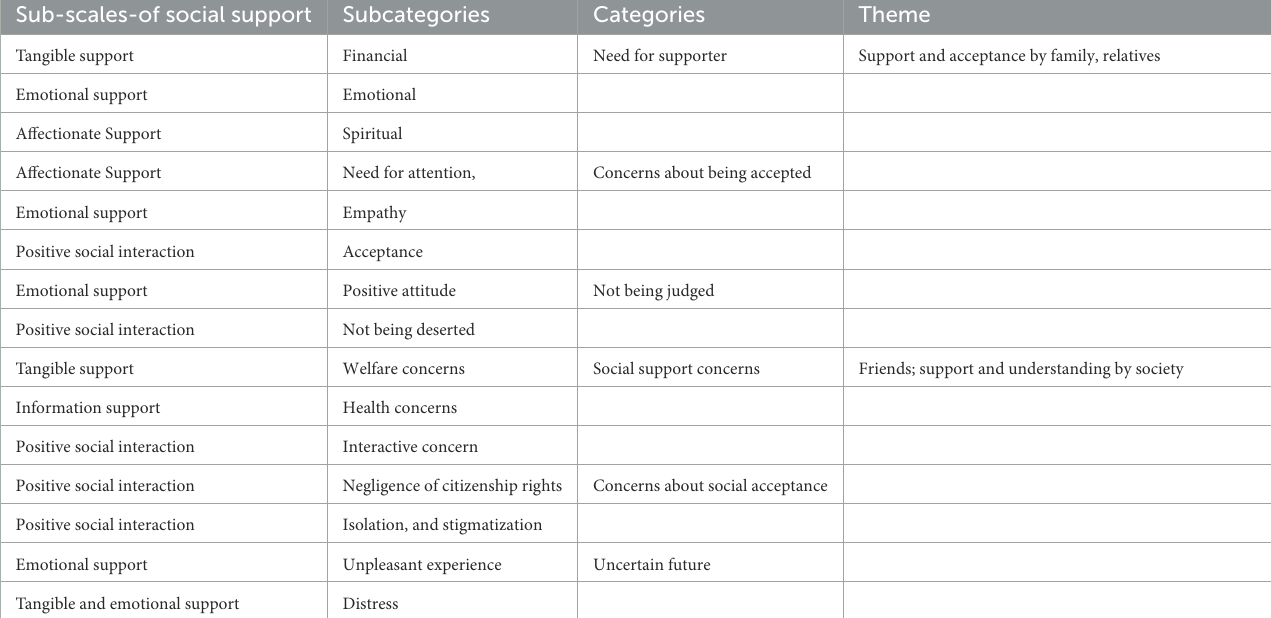
TABLE 5 Lists the categories and subcategories in qualitative phase versus of sub-scales-of social support in quantitative